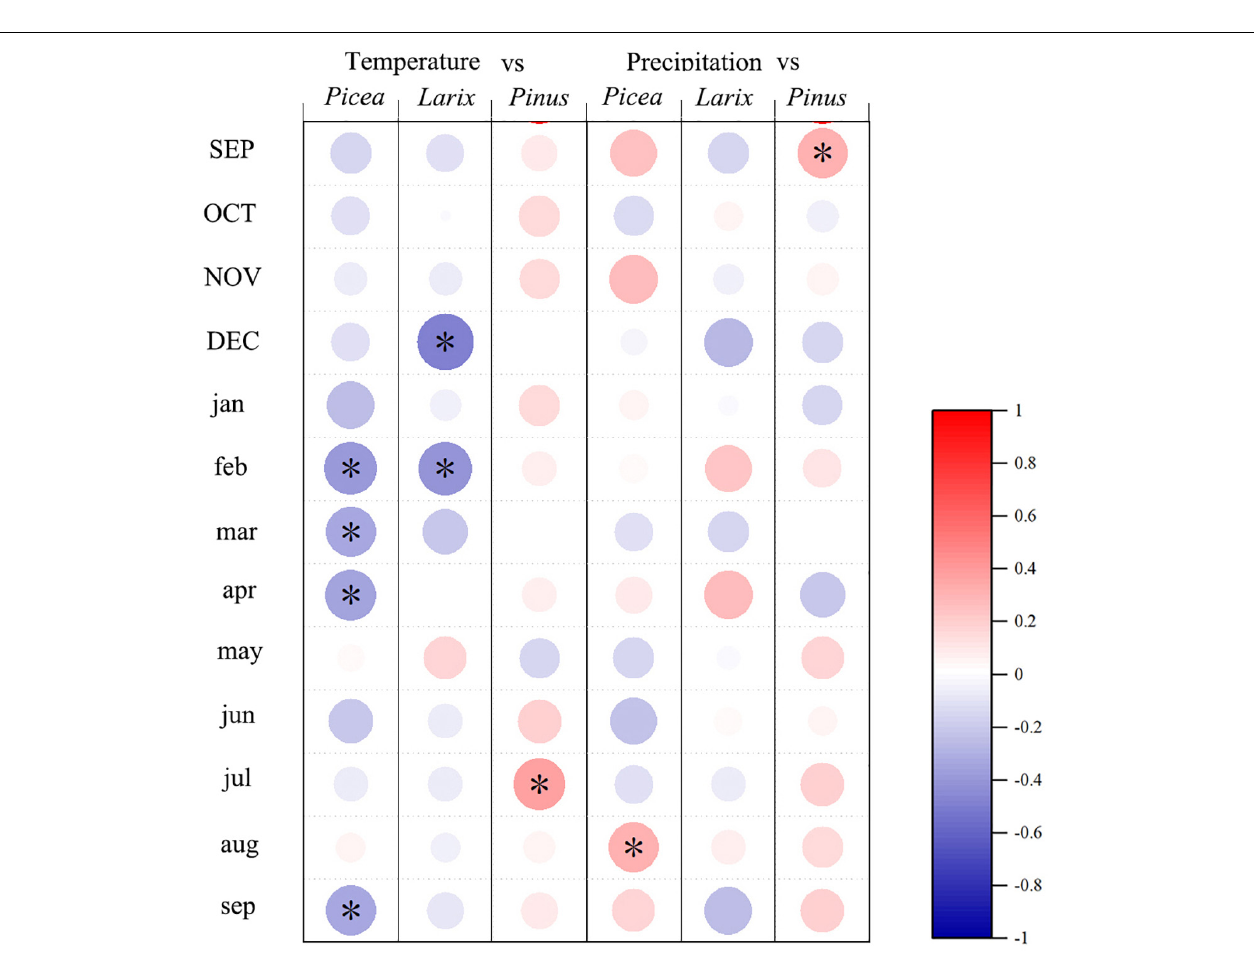
FIGURE 4 | Pearson correlation coefficients between monthly climatic factors and ring width indices for Pinus koraiensis , Larix olgensis , and Picea jezoensis . Sizes of the circles indicate the strengths of the correlation coefficients. The gradual change of color from blue to red indicates a gradual change of correlation from negative to positive. The capitalized months mean them from the past year, and the lowercase from the current year. The “ ∗ ” indicated a significance p <